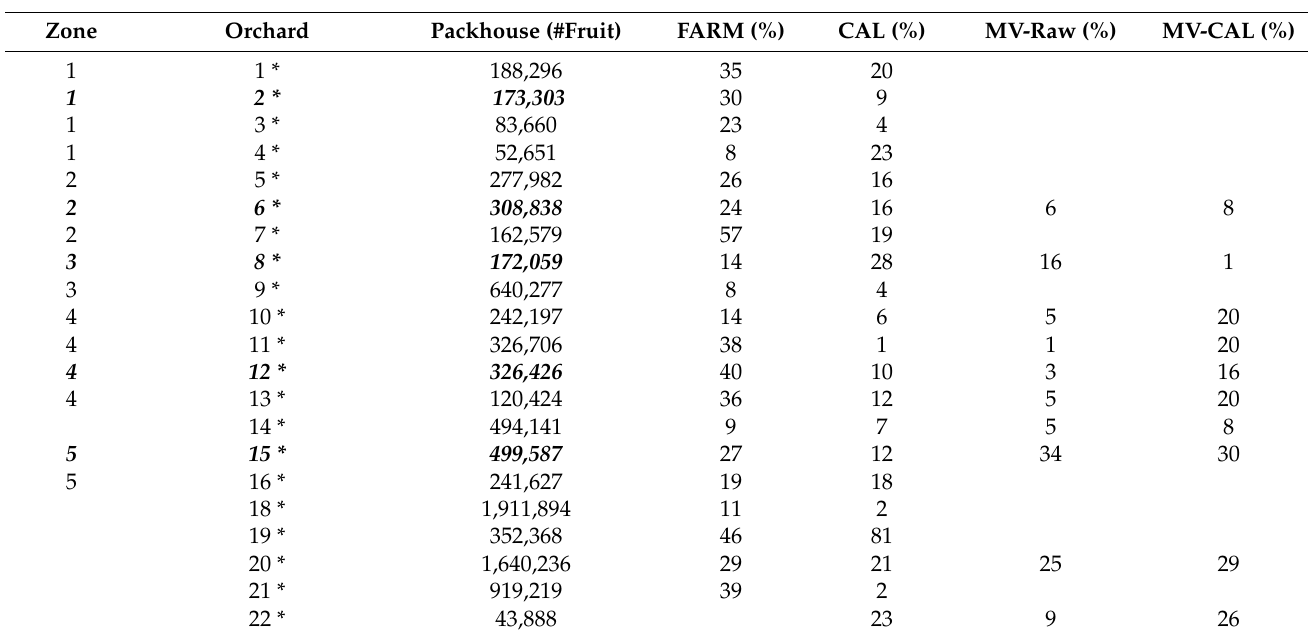
Table 2. Packhouse fruit count and the absolute percentage error of fruit load estimates made by (i) farm management as a manual count of a systematic sample of trees (FARM), (ii) a manual count of calibration trees multiplied by tree number (CAL), (iii) the raw machine vision count (MV-Raw) and (iv) a machine vision count adjusted by an ‘occlusion’ factor calculated of the calibration trees (MV-CAL). Calibration trees were located in the orchards highlighted by bold italic font for a given management zone. Occlusion factors calculated from these trees were applied to other orchards of the same management zone for calculation of CAL and MV-CAL. In orchards designated by *, packhouse fruit numbers represents estimates based on tray numbers and tray sizes. Significant differences ( p > 0.05) between treatment averages are denoted with